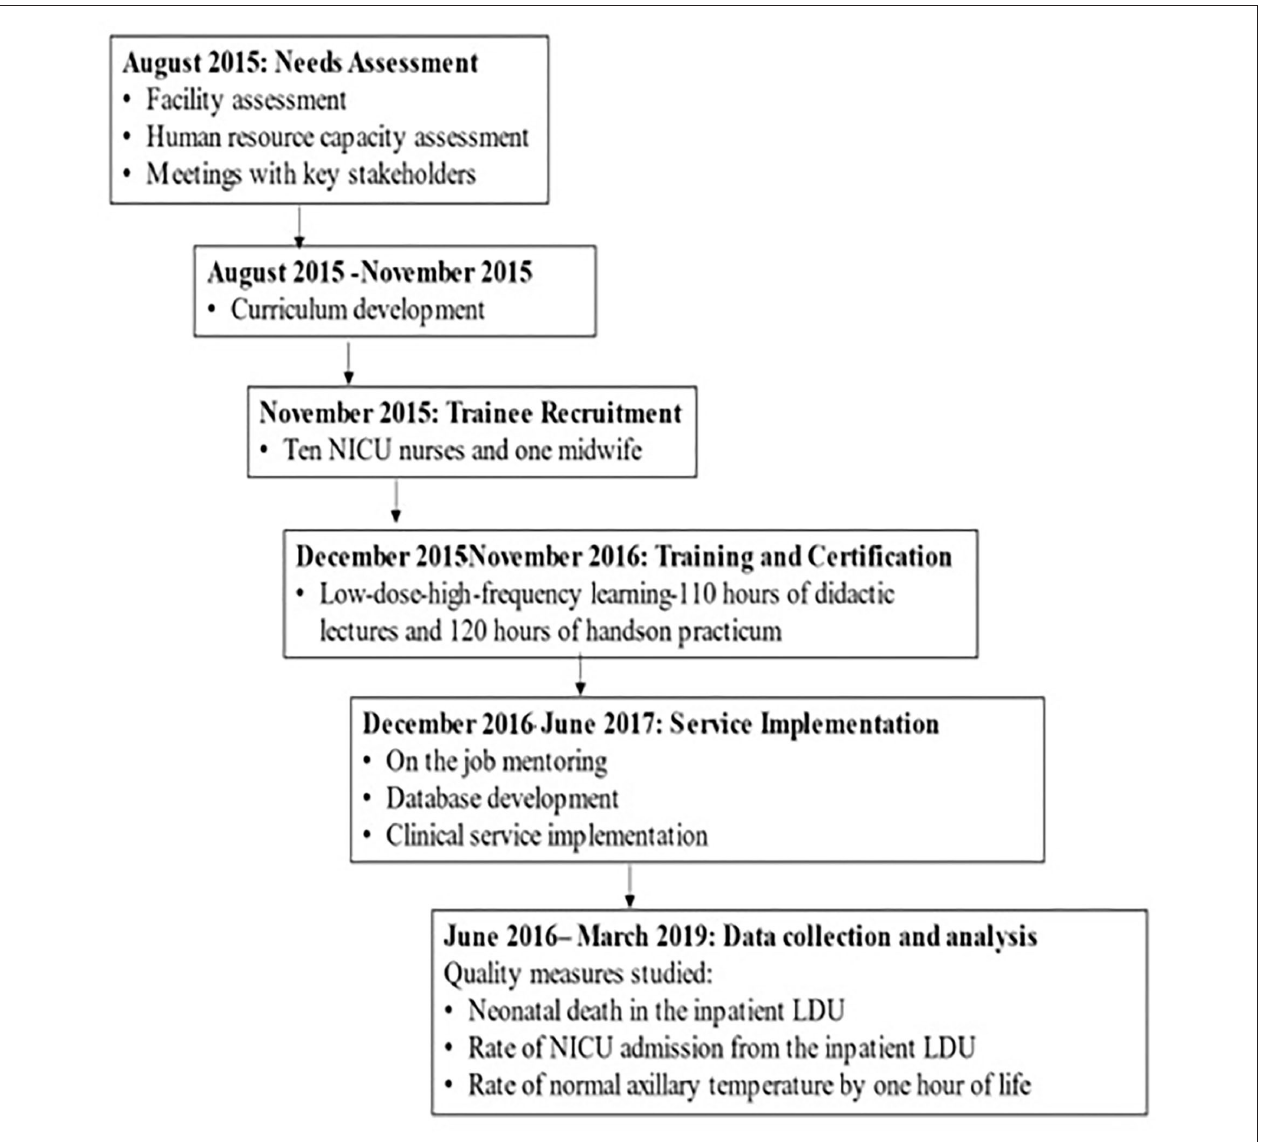
FIGURE 2 | Timeline of project design, implementation, and study.